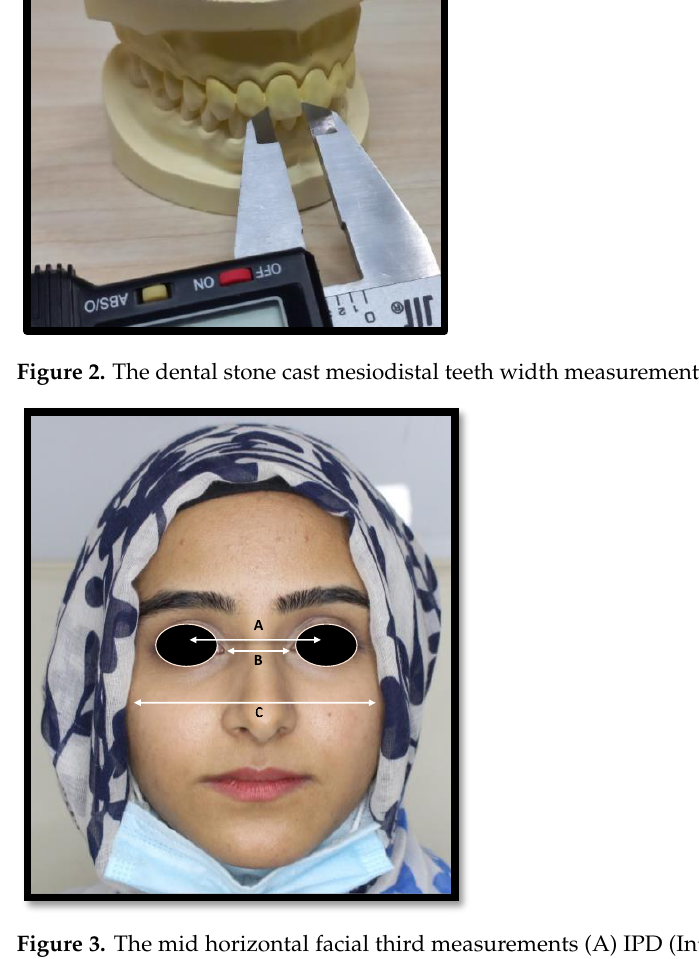
Figure 2. The dental stone cast mesiodistal teeth width measurements with a Vernier caliper.